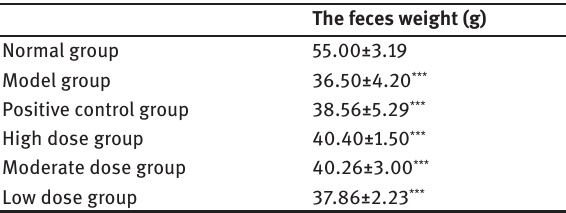
Table 1: The feces weight of rats at 24 h after treatment.